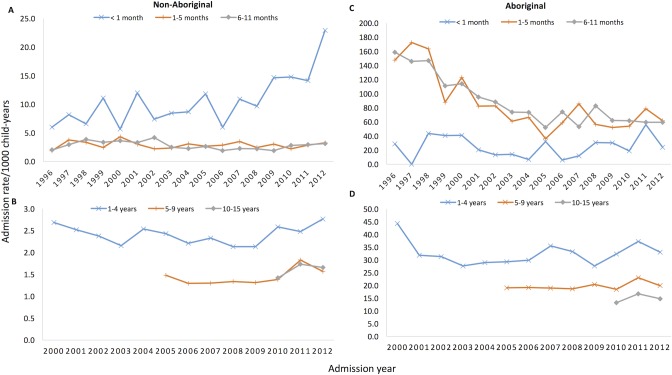
Skin infection hospital admission rates in children in Western Australia, 1996–2012.Shows rates in non-Aboriginal (A & B) and Aboriginal (C & D) children. The calculated admissions included all hospital discharge records with evidence of scabies, impetigo and pyoderma, cellulitis, abscess, fungal infections, head lice and other skin infections. Note the differences in scale. In children aged 1–4 years, the admission rate of skin infection was 34.1/1000 in Aboriginal children and 2.5/1000 in non-Aboriginal children (Table 2). In Aboriginal children of this age group, significant declines were mainly seen in admissions for scabies (4.2%), impetigo and pyoderma (2.7%), and cellulitis (5.0%). Conversely, abscess increased by 2.1% in Aboriginal children (P = 0.03). In children aged 5–9 years and 10–15 years, the highest rates of admissions were for abscess, while the highest disparity in admissions between Aboriginal and non-Aboriginal was due to scabies. There were no significant changes in admission rates during the follow-up period in both these age groups.